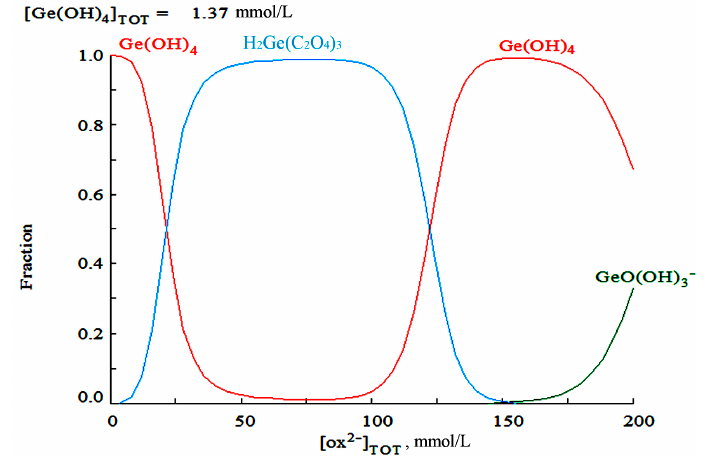
Figure 3. Species of germanium in various oxalic acid concentrations and 100 mg/L Ge (calculated by Medusa software, KTH university, Stockholm, Sweden).